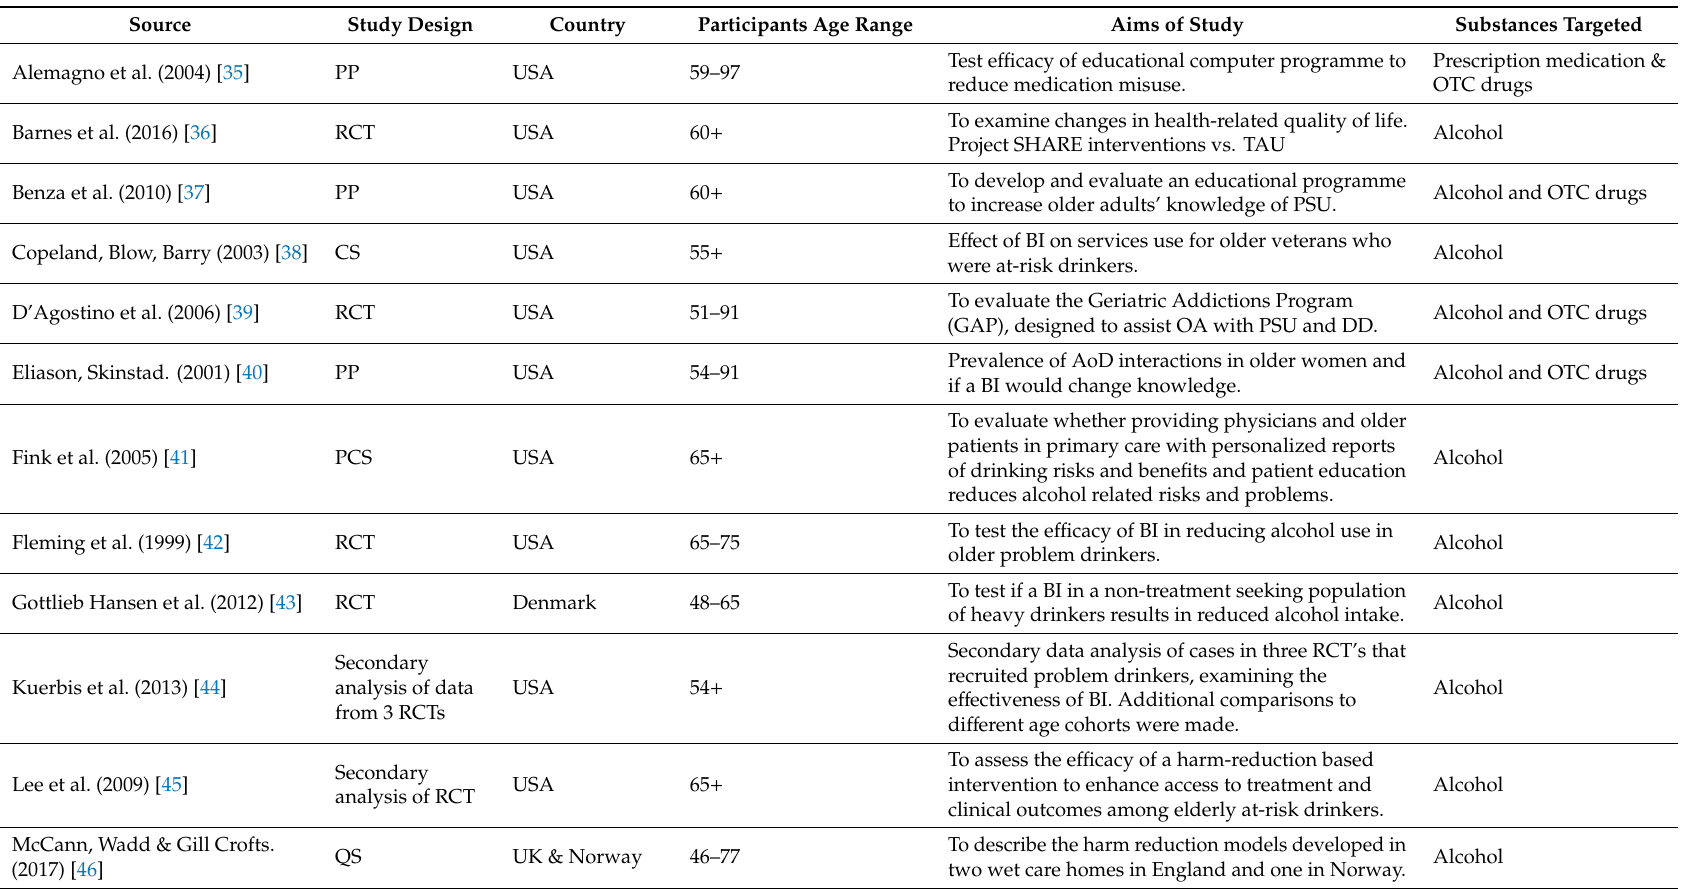
Table 3. Overview of key study